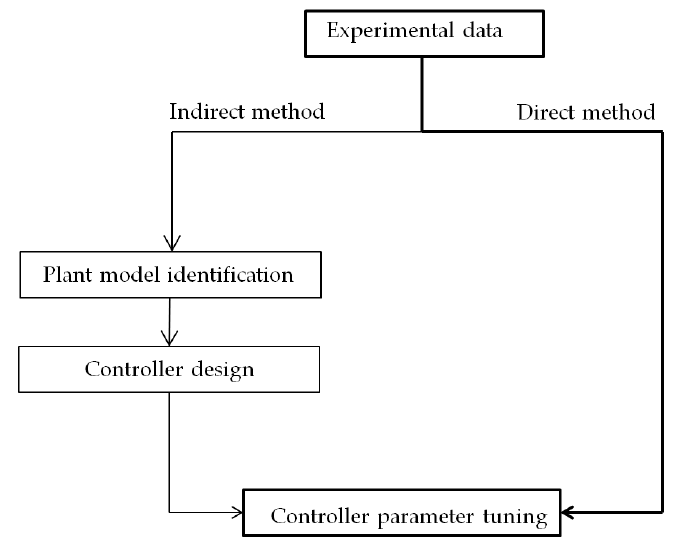
Figure 6. Data-driven control methods.